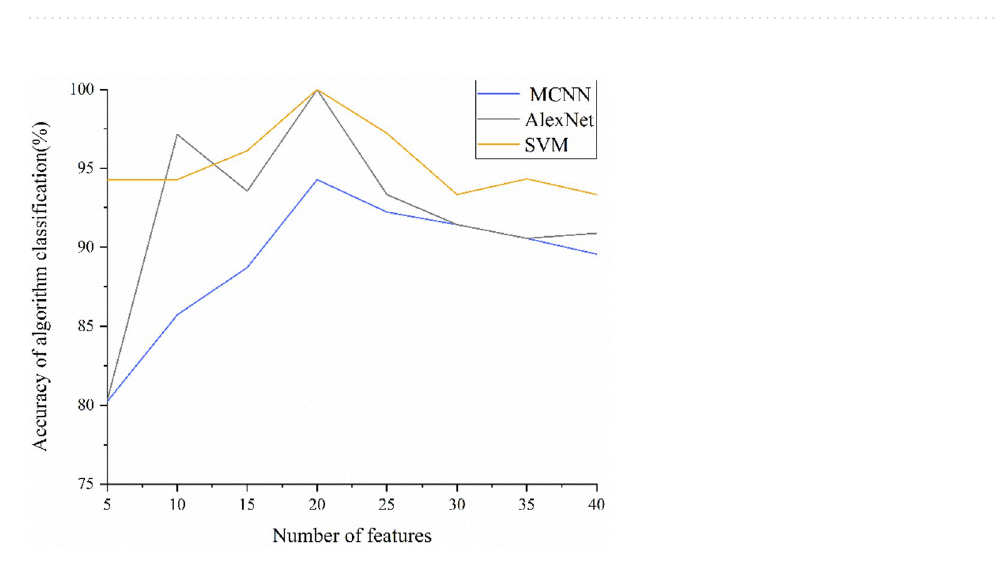
Table 3. Validation set experimental results of SVM, AlexNet and MCNN.